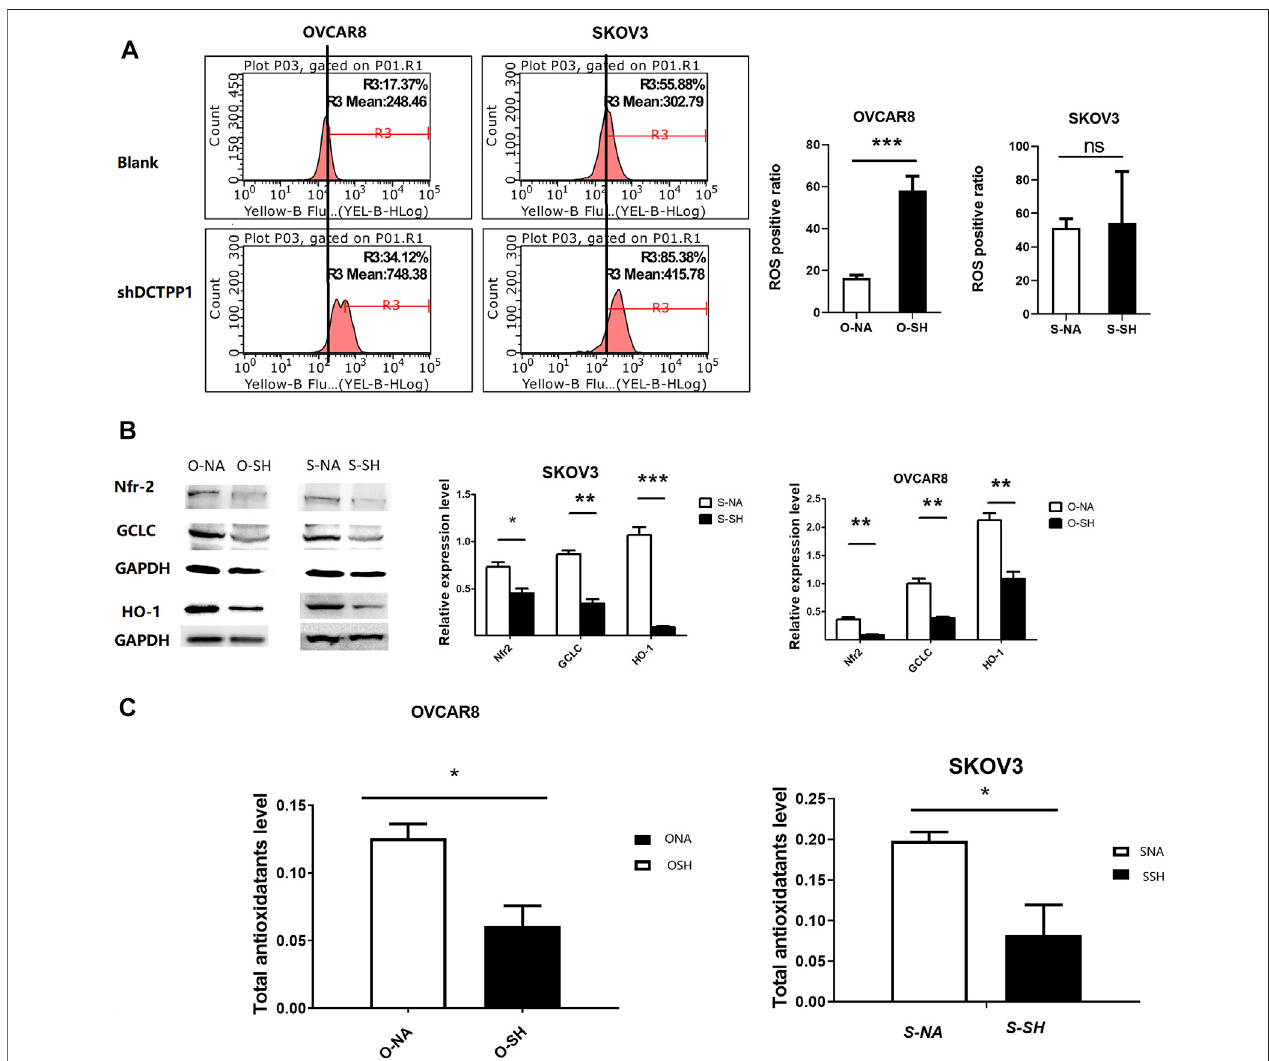
FIGURE 4 | DCTPP1 knockdown induces ROS overproduction in ovarian cancer cells. (A) The level of reactive oxygen species (ROS) was detected using DHE in control or DCTPP1 knockdown cells.***, p < 0.001; ns, no signi fi cance. (B) Western blot analysis and densitometric quanti fi cation of Nrf2, GCLC and HO-1in ovarian cancercellstransfectedwithshRNAandthecontrolrespectively.Dataarepresentedasmean±SEM.* p < 0.05;**, p < 0.01;***, p < 0.001; (C) Totalantioxidotatantslevel of ovarian cancer cells transfected with shRNA and the control respectively. Data are presented as mean ± SEM. p p < 0.05.